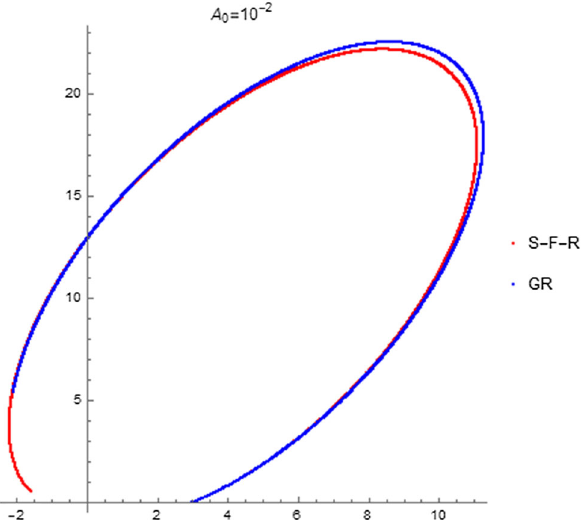
Fig. 2 This is a polar graph of the timelike paths that we find using our theoretical SFR (red curve) model in comparison to the geodesics of GR (blue line) for E = 0 . 98, L = 1, r 0 = 3 and ( a , b , c ) = ( 1 , 1 , 1 ) the energy E =